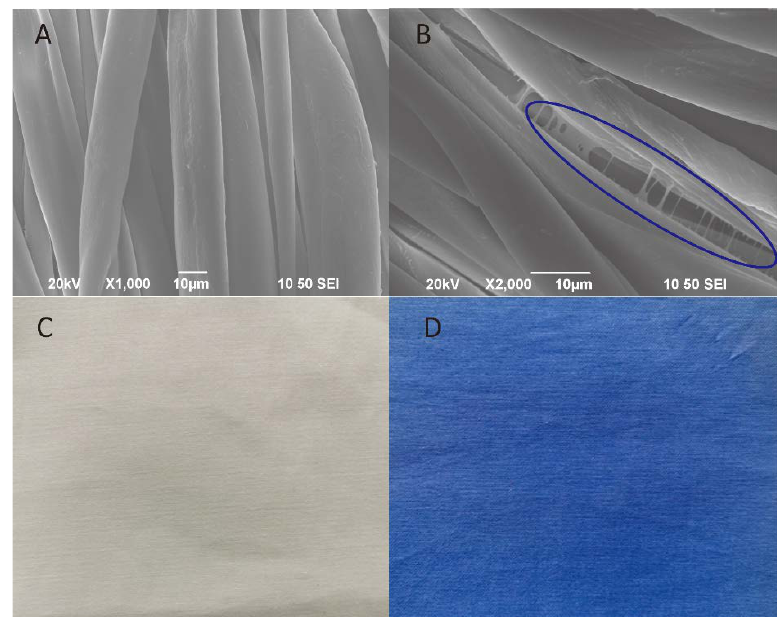
Figure 2. Surface morphology of treated fabric observed by SEM: ( A ) untreated cotton fabric, ( B ) fabric treated with PHMB, and optical photographs: ( C ) untreated cotton fabric and ( D ) PHMB-coated fabric dyed with bromophenol blue (BPB).